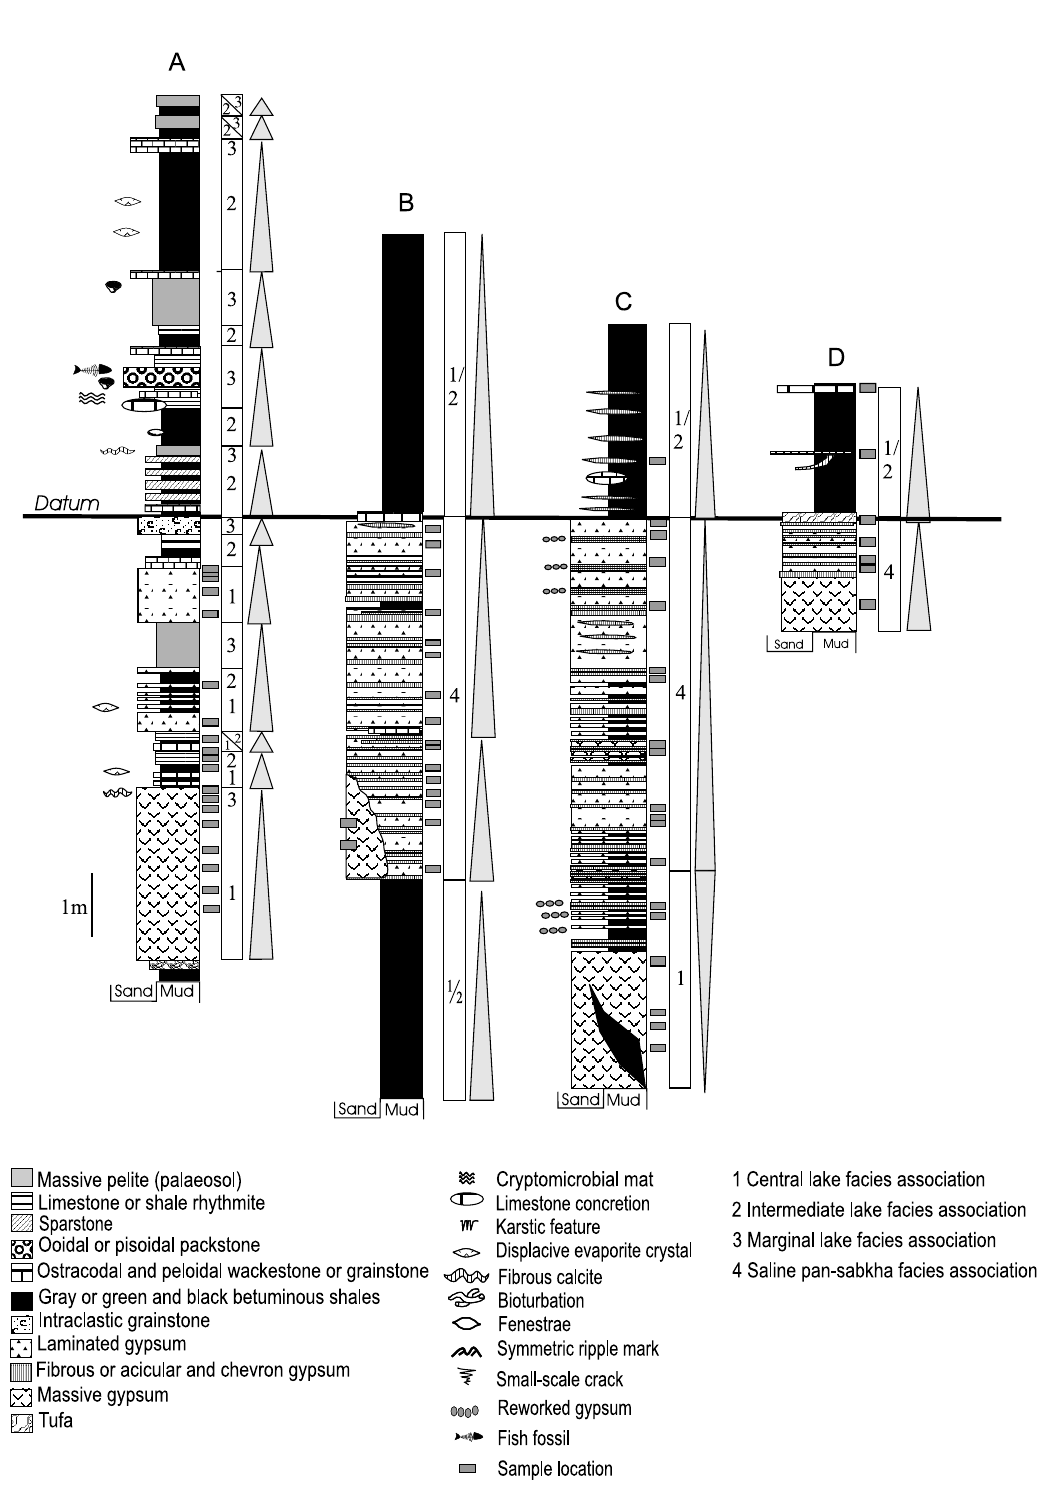
Fig. 4 – Measured vertical sections representative of the evaporites studied in the Codó Formation (see Fig. 1 for section location).